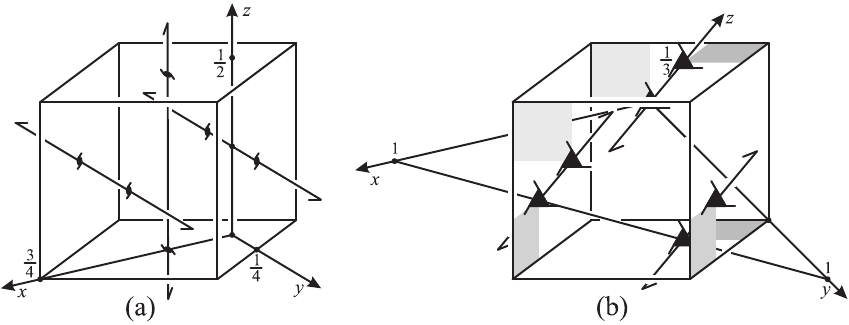
Figure 7. Two examples for face identifications of the cube generating fixed point free fundamental cube tilings in the Euclidean space. The generated groups are P2 1 2 1 2 1 ( a ) and P3 1 ( b